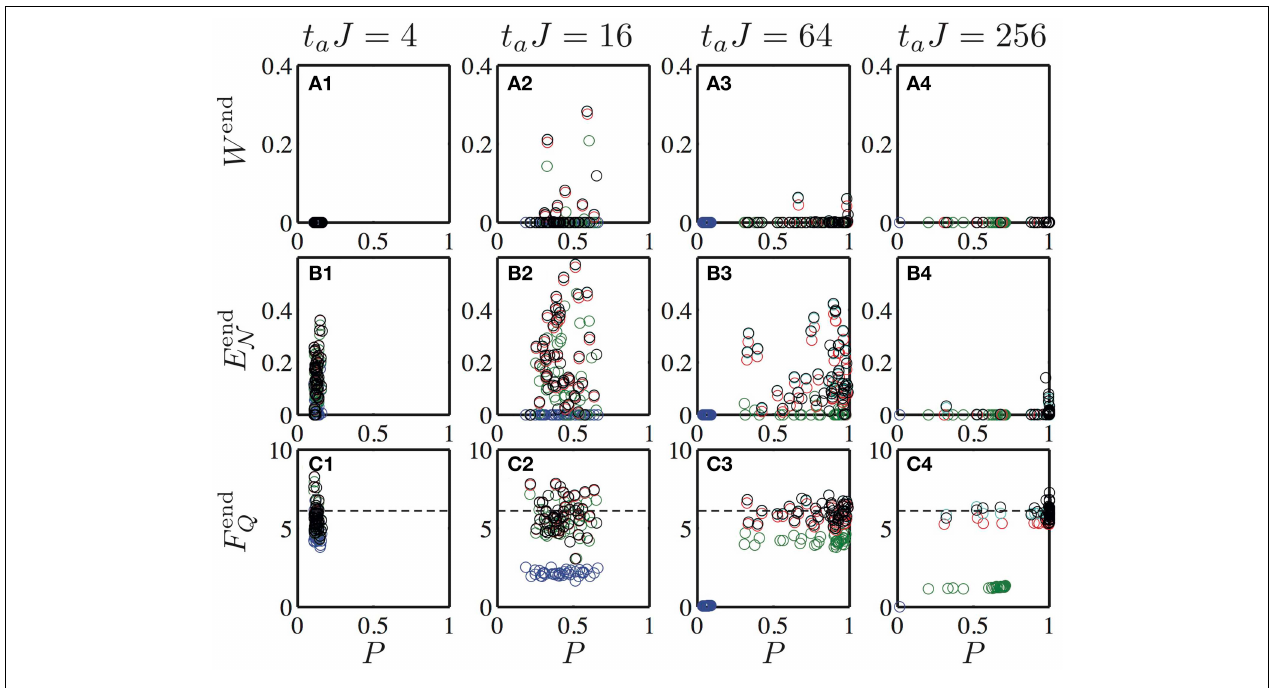
with a small success probability. Fisher information and logarithmic negativity FIGURE 6 | Scatter plot of success probability P against the witness show some residual entanglement. At large t a , the success probability (top), logarithmic negativity (middle), and Fisher information (bottom) decreases with increasing decoherence rate, which also suppresses for N = 6 spins. Colors indicate the decoherence rate, ranging from Ŵ 0 = logarithmic negativity and Fisher information. The dashed line marks F Q (black), Ŵ 0 . 0001 J (red), Ŵ 0 . 001 J (green), to Ŵ 0 . 01 J (blue). For small = = = above which the system hosts t a , the final state is always close to an equal superposition of all eigenstates